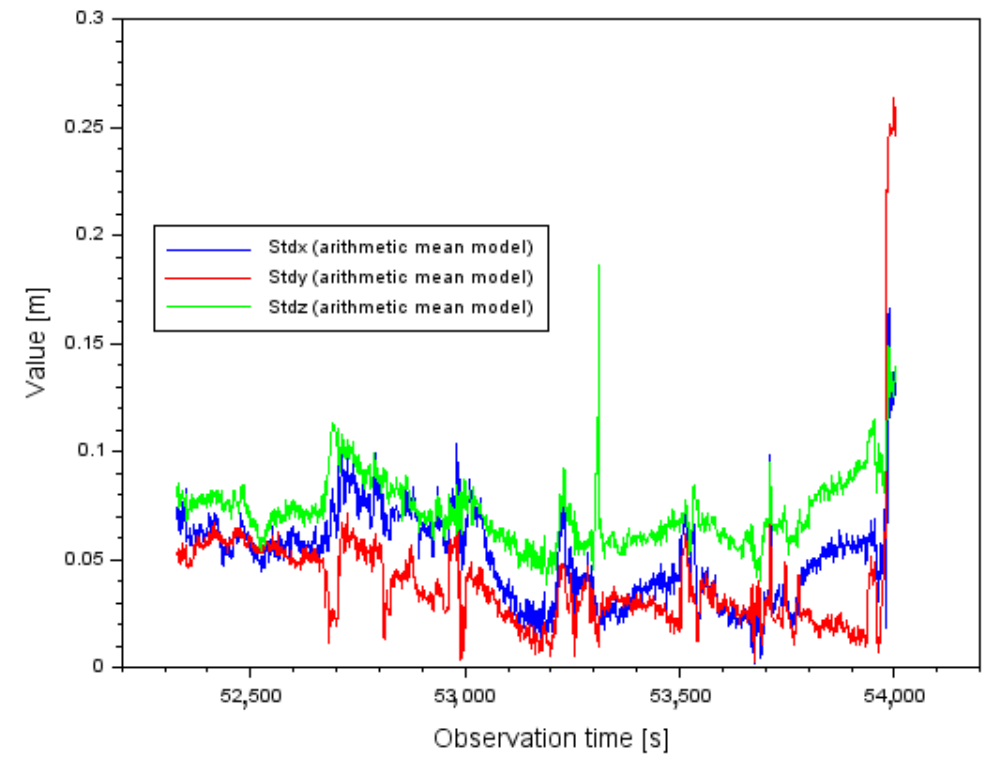
Figure 13. The values of standard deviation based on arithmetic mean model.